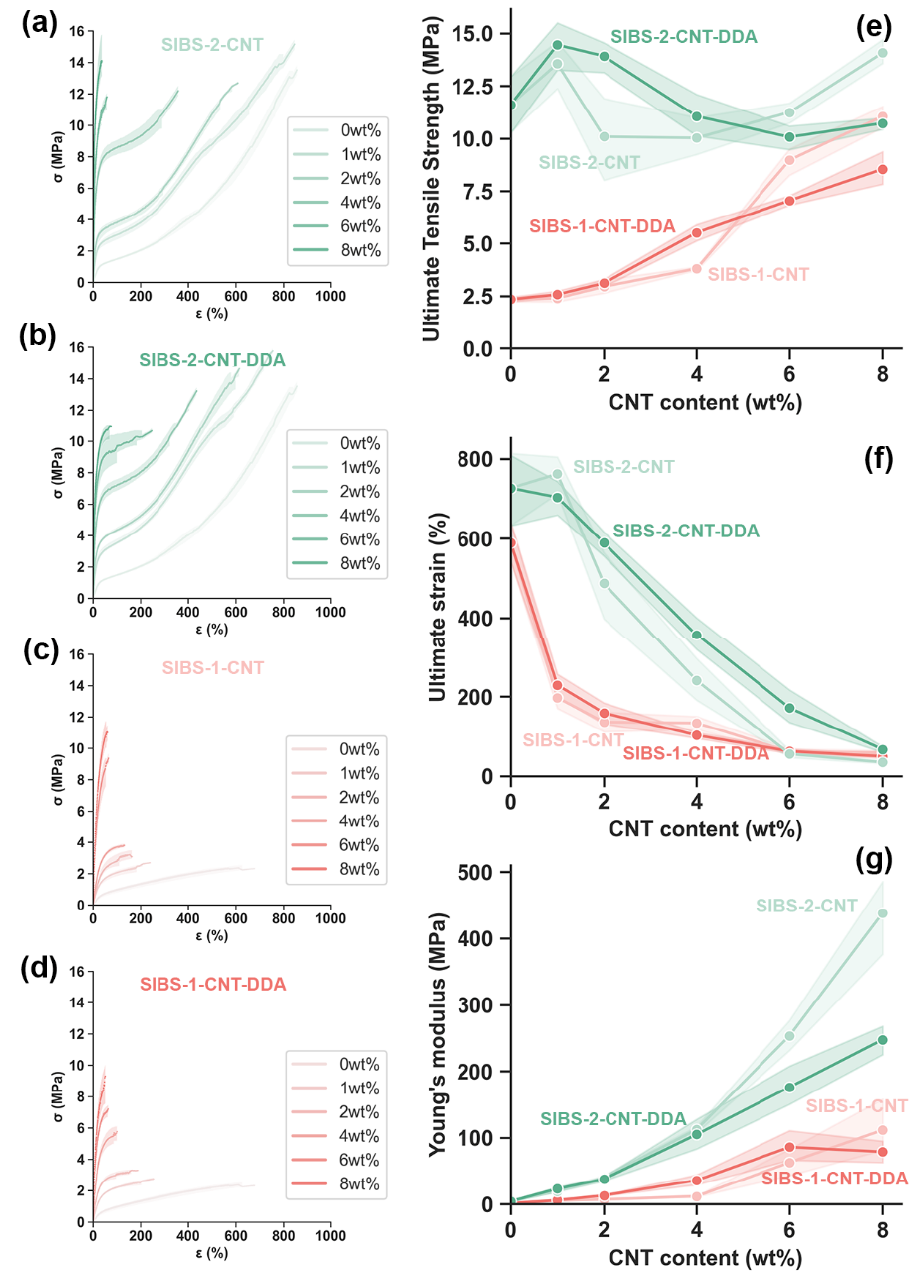
Figure 6. The mechanical properties of SIBS nanocomposites: Engineering stress-strain curves of ( a ) SIBS-2-CNT, ( b ) SIBS-2-CNT-DDA, ( c ) SIBS-1-CNT, ( d ) SIBS-1-CNT-DDA; Relationship between the CNT content and ( e ) ultimate tensile strength, ( f ) ultimate strain, ( g ) Young’s modulus. SIBS-2 with high molecular weight and without nanofiller provides ultimate tensile stress of 11.62 MPa, ultimate strain of 726%, and Young’s modulus of 0.77, demonstrating the prospects of its application in medical devices that require high elasticity, strain density, and a margin of safety. At the same time, the modification of 1wt% SIBS-2-CNT-DDA leads to an increase of the ultimate tensile stress to 14.45 MPa ( p < 0.01) while maintaining its elastic modulus ( p = 0.99). Subsequent increasing of CNTs concentration improves the rigidity of the material but does not lead to an increase in its tensile